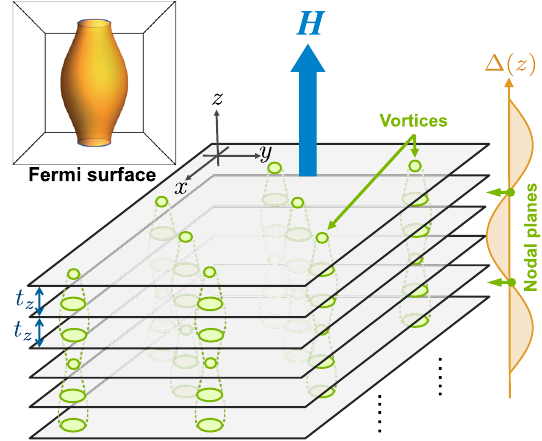
FIG. 1. Schematic figure illustrating a layered superconductor in the out-of-plane magnetic field, open Fermi surface, and the emerging vortex state with interlayer Larkin-Ovchinnikov modu-